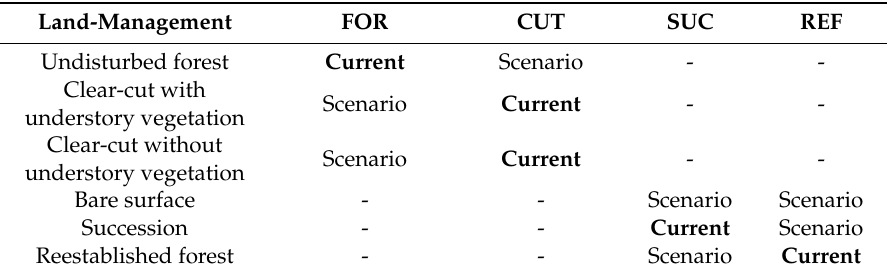
Table 3. Land-management stages defined for modeling.